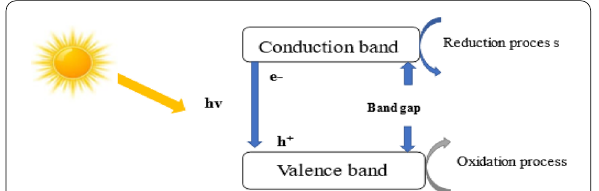
Fig. 1 Schematic representation of the photocatalysis